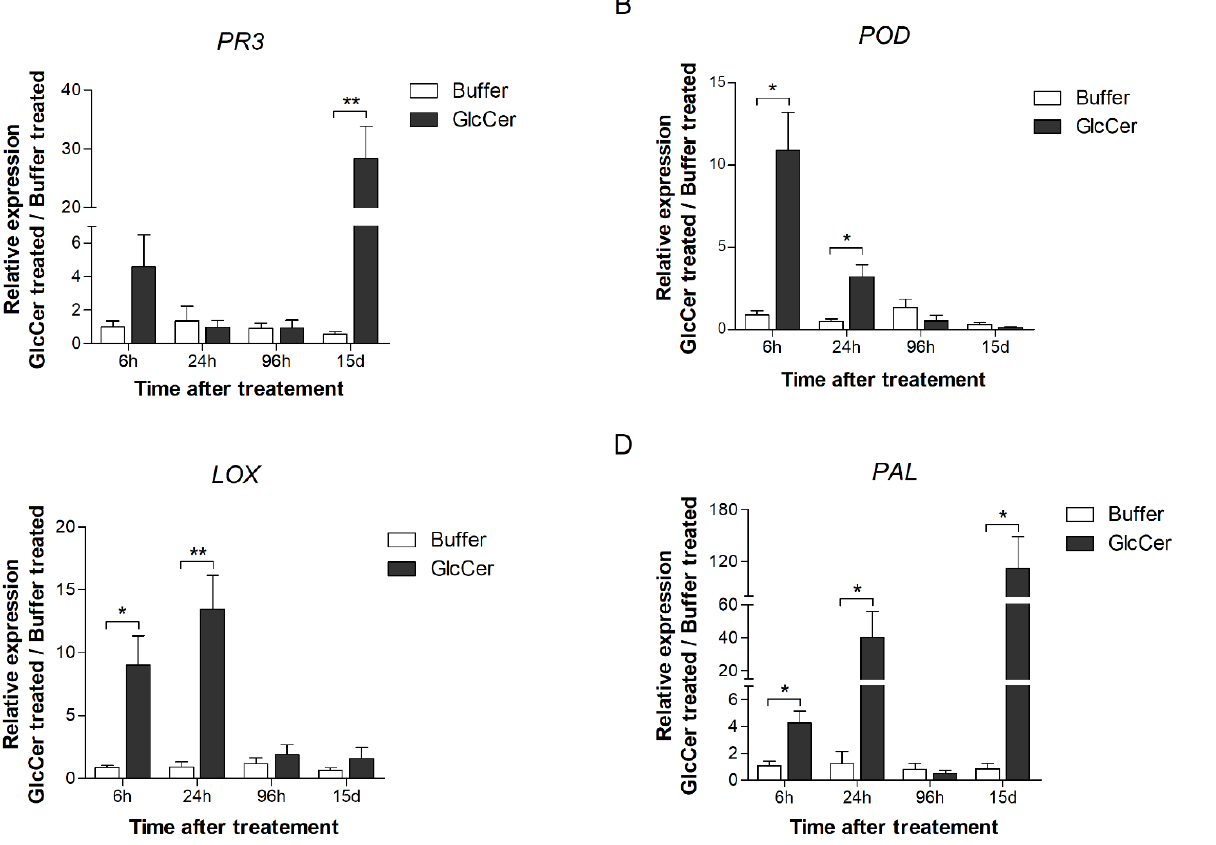
Figure 7. Expression of genes related to the plant defense of P. edulis treated with C. herbarum GlcCer at different time points. ( A ) PR3 gene analysis (chitinase); ( B ) POD gene analysis (peroxidase); ( C ) LOX gene analysis (lipoxygenase) and ( D ) PAL gene analysis (phenylalanine ammonia lyase). Constitutive genes used for normalization: NDID (NADP-dependent isocitrate dehydrogenase) and ERS (Ethylene Response Sensor). The analyses were made from the average of two biologically inde- pendent experiments and technical triplicate of each biological replicate, and the relative expression was calculated by the 2 − ∆∆ Ct method. Asterisks denote values statistically different from control. * p < 0.05, ** p < 0.01.